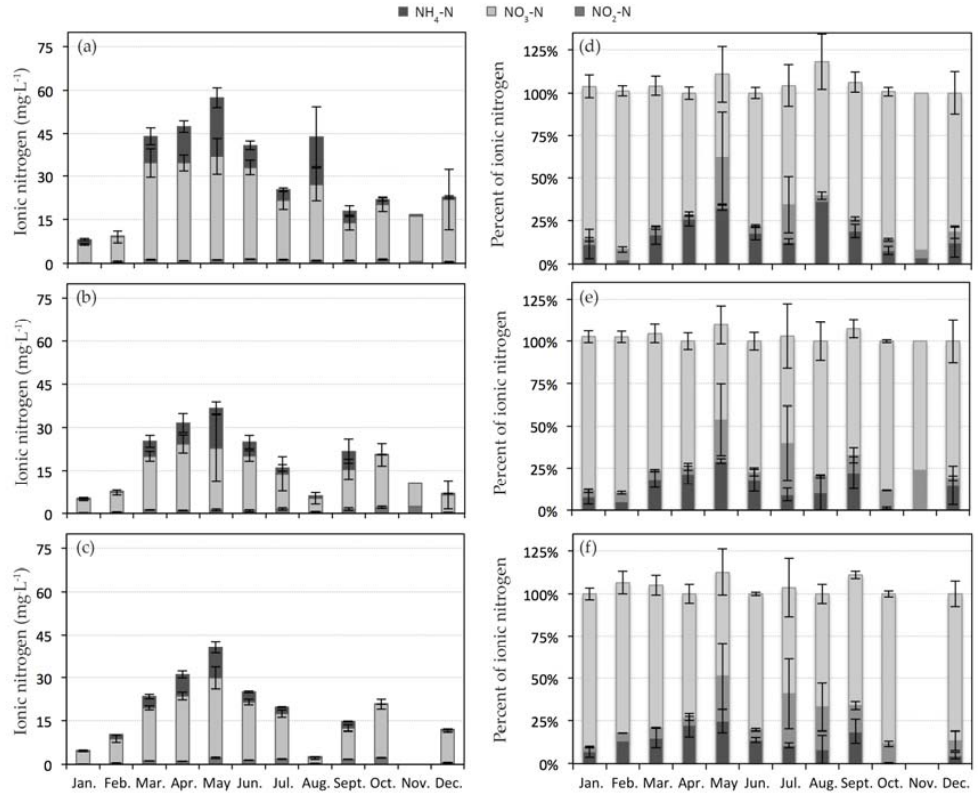
Figure 2. The concentration and percent of ionic nitrogen (nitrite (NO 2 -N), nitrate (NO 3 -N) and ammonium (NH 4+ -N)) detected within sites in Constructed Wetland 1 (CW1): ( a , d ) Site 1.1 (inflow ditch/runoff channel); ( b , e ) Site 1.2 (retention pond); and ( c , f ) Site 1.3 (direct inflow to Stage 1 of CW1). Error bars represent the standard error ( ± ) of the mean value. Table 2. Annual average ( ± standard error) concentration and percent of total ionic N (nitrate (NO 3 -N), nitrite (NO 2 -N) and ammonium (NH 3 -N)) in two constructed wetland (CW) by sampling